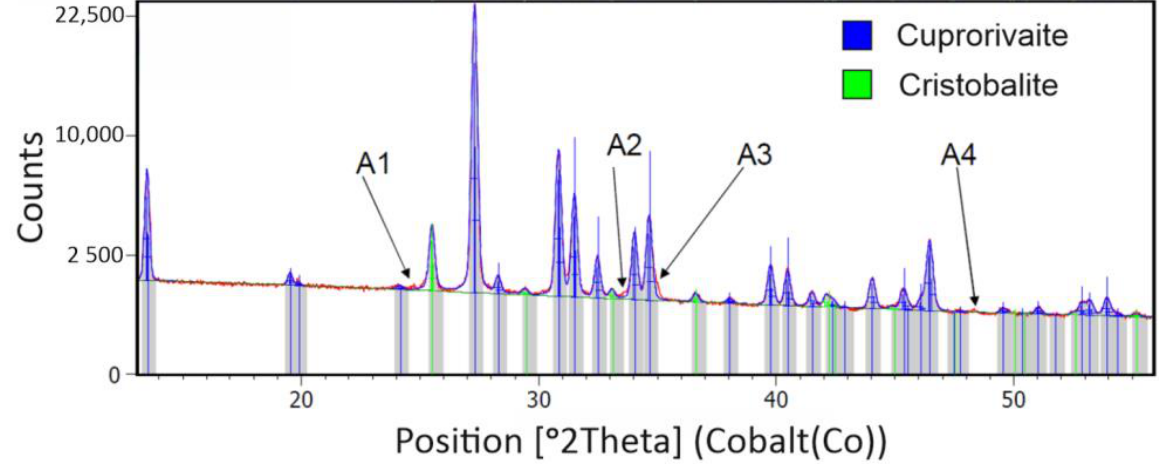
Figure 7. XRD pattern of Egyptian blue after horizontal bead mill treatment with two significant phases detected: cuprorivaite and cristobalite. Arrows A1–A4 indicate disturbances in the intensity distribution. The intensity distribution (A1, A2, A3 and A4) may indicate the presence of other phases in the sample at the limit of detection of the applied research method. Lattice parameters with respect to dispersion method are presented below (Table